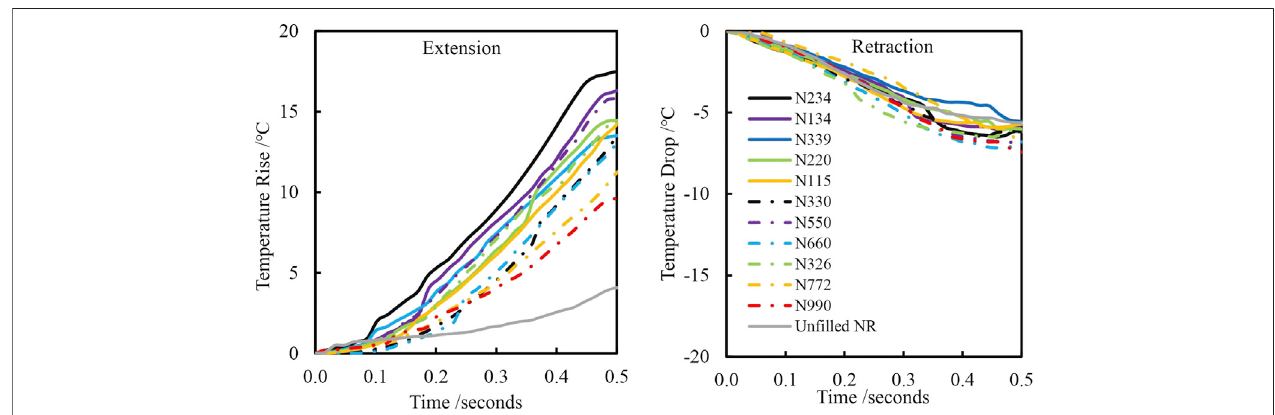
FIGURE7| Temperatureriseandtemperaturedropofcarbonblackreinforcedandunreinforcednaturalrubberextendedto350%strainandretractedaftera2 min hold for 1st cycle.